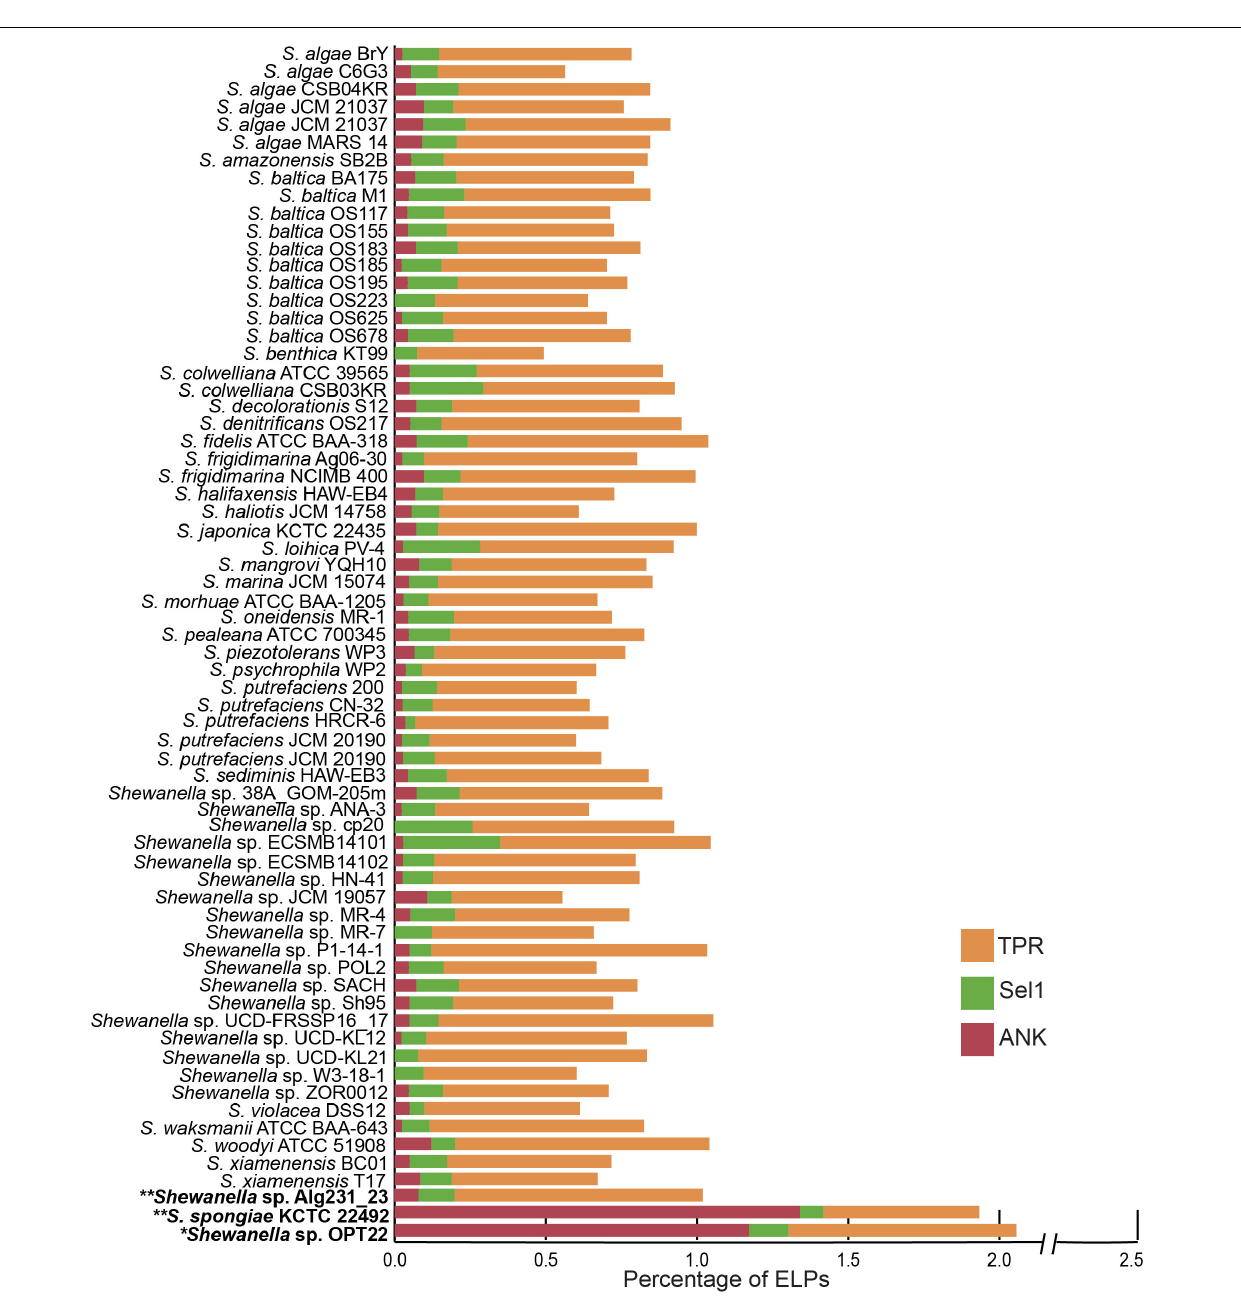
FIGURE 5 | Staked bar plot showing the percentage abundance of eukaryotic-like proteins (ELPs) detected in the genus Shewanella . A total of 68 genomes were compared for the presence of proteins-containing ELPs- ankyrin-repeat (ANKs), tetratrico peptide repeats (TPRs), and Sel1 repeats. The strains isolated from the sponges are shown in bold. Single and double asterisks denote the genomes sequenced in this study and in previous studies,